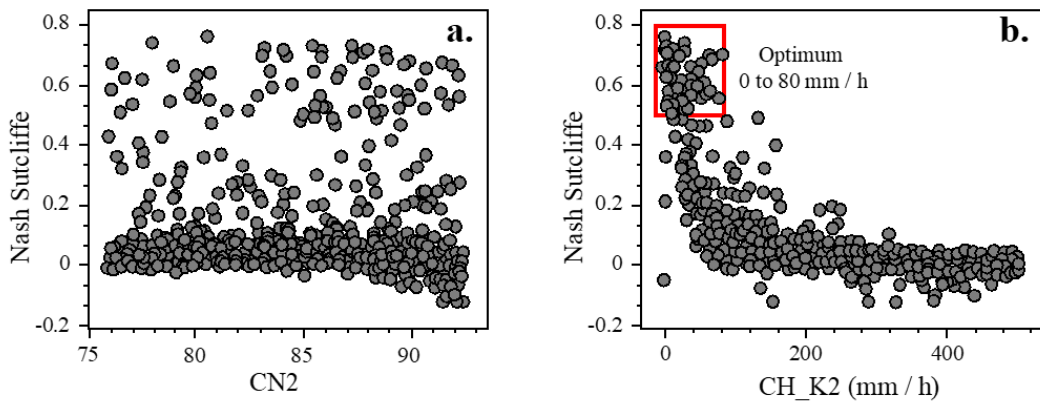
Figure 2. Dotty plots for BV basin. ( a ) NS versus CN2 and ( b ) NS versus CH_K2 parameter value with zone of optimum performance indicated. Table 4. Highly sensitive parameters (HSP) from IT_Q simulation.